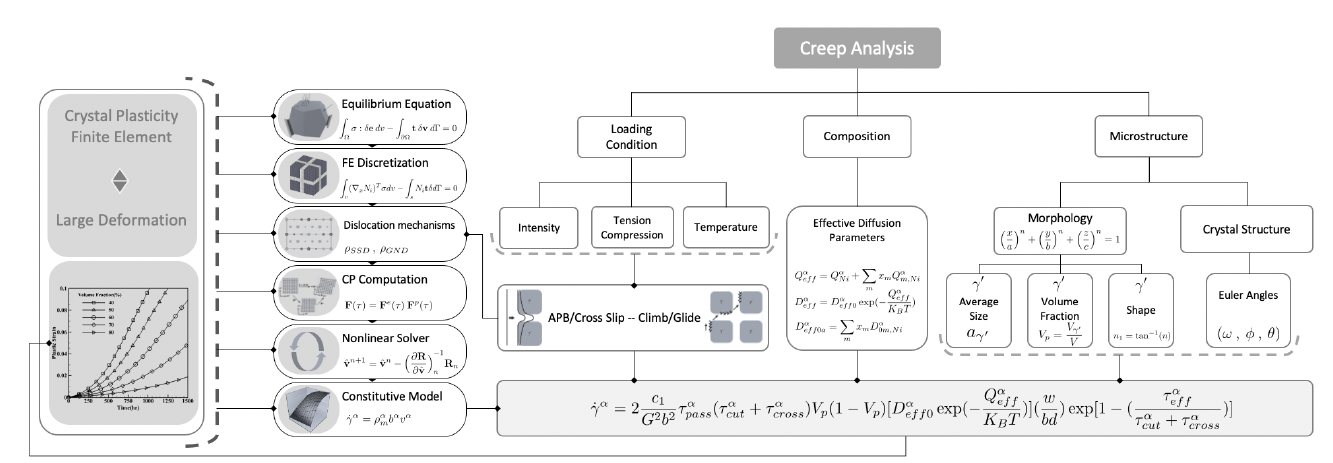
Figure 4. Computational steps to capture creep responses in the CPFE framework.